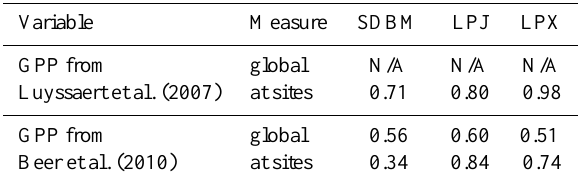
Table 6. Mean annual gross primary production (GPP) normalised mean error (NME) comparison metrics using Luyssaert et al. (2007) and Beer et al. (2010) as alternative benchmarks. In the case of Beer et al. (2010), the comparisons are made for all grid cells (global) and also from the grid cells which contain sites in the Luyssaert et al. (2007) dataset (at sites). Variable Measure SDBM